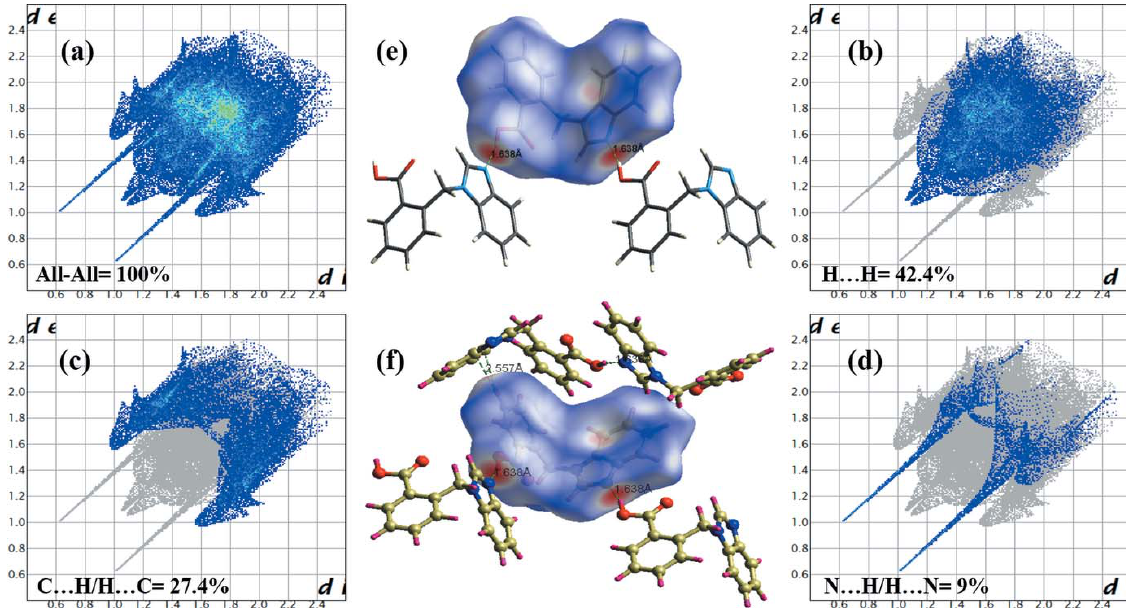
Figure 4 The Hirshfeld surface of the title compound mapped over d norm , in the range (cid:4) 0.722 to 1.183. ( a ) The overall two-dimensional finger plot of the title compound and those delineated into ( b ) H (cid:3)(cid:3)(cid:3) H (42.4%), ( c ) C (cid:3)(cid:3)(cid:3) H/ H (cid:3)(cid:3)(cid:3) C (27.4%) and ( d ) N (cid:3)(cid:3)(cid:3) H/H (cid:3)(cid:3)(cid:3) N (9%) interactions, ( e ) significant hydrogen bonding and ( f ) extended supramolecular form.